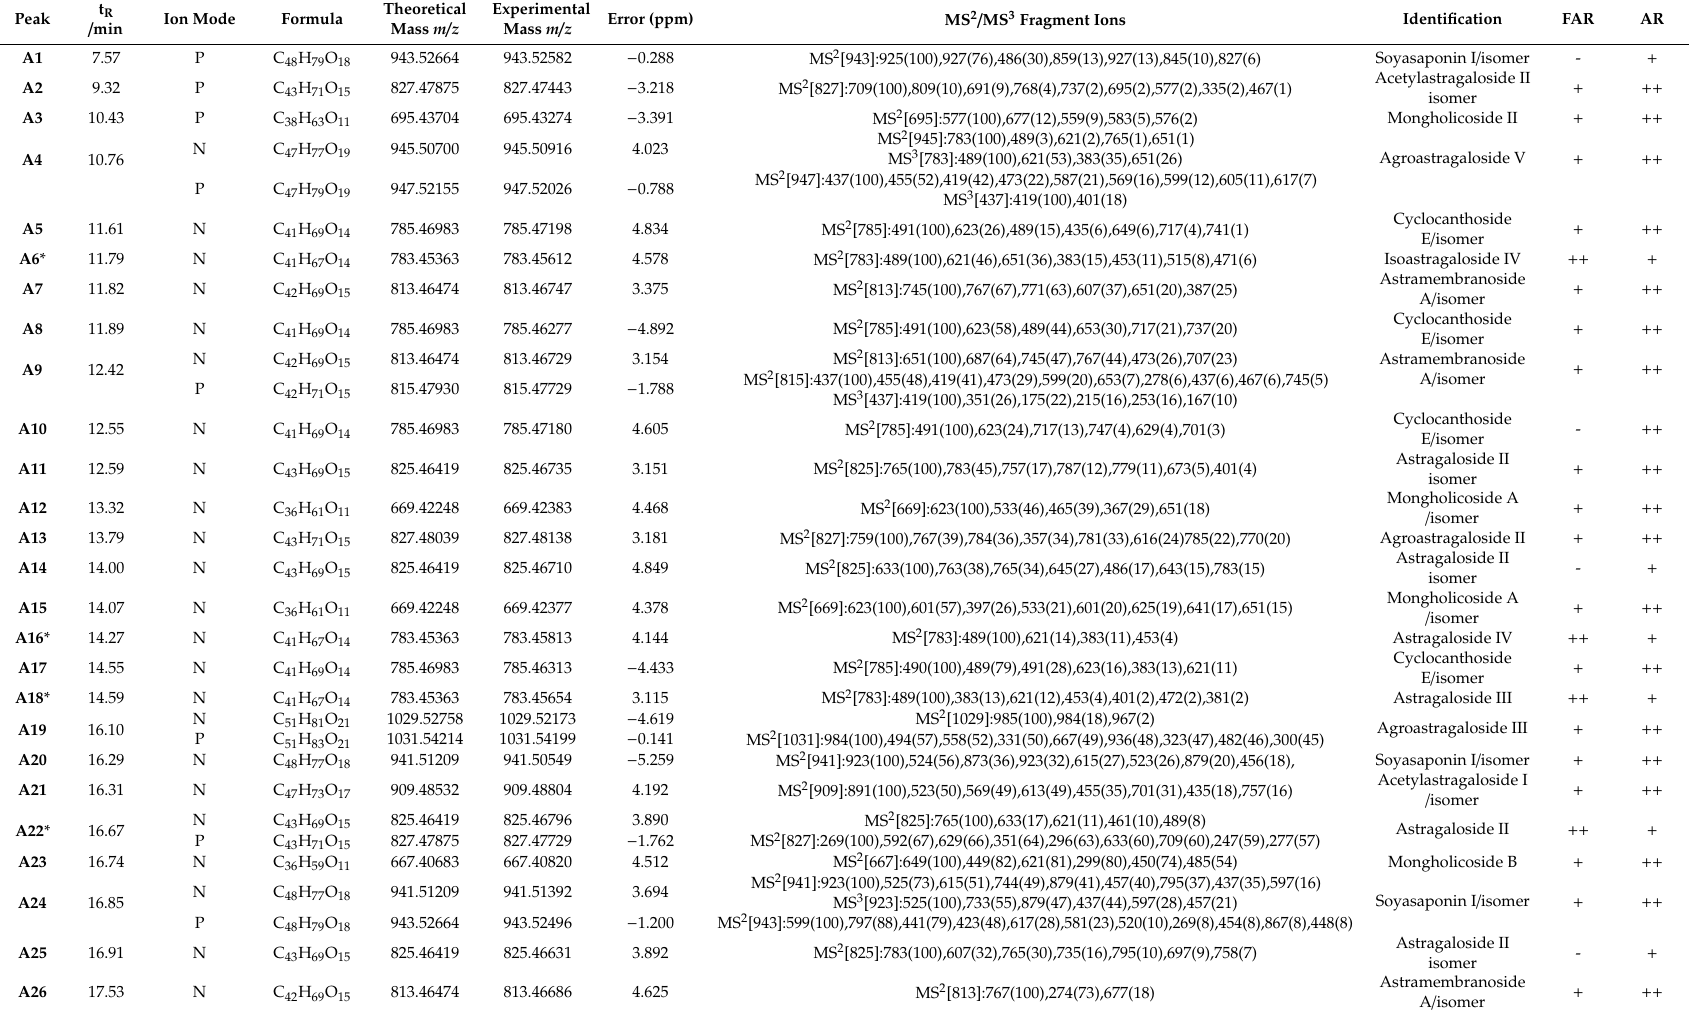
Table 1. Summary of identified saponins in Astragli Radix (AR) and fermented AR